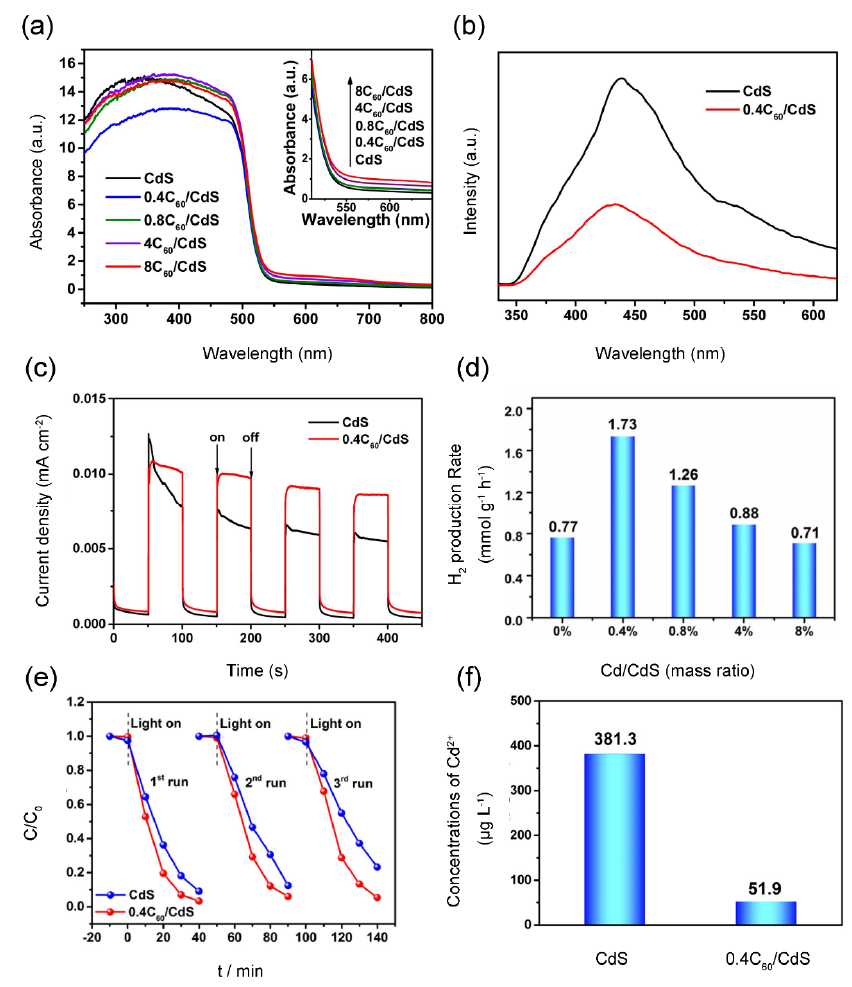
Figure 5. UV-vis spectra ( a ), PL emission spectra ( b ) and transient photocurrent responses ( c ) in 0.5 M Na 2 SO 4 solution of CdS and C 60 / CdS nanocomposites. ( d ) The photocatalytic rate of H 2 generation over C 60 / CdS samples under visible light illumination. ( e ) Recyclability test of photodegradation towards RhB under visible light illumination over CdS and 0.4C 60 / CdS composite. ( f ) Comparison of Cd 2 + concentrations in the solutions of CdS and 0.4C 60 / CdS photocatalysts after three cycles for RhB degradation. Reproduced with permission from Reference [43]. Copyright 2017, Elsevier.